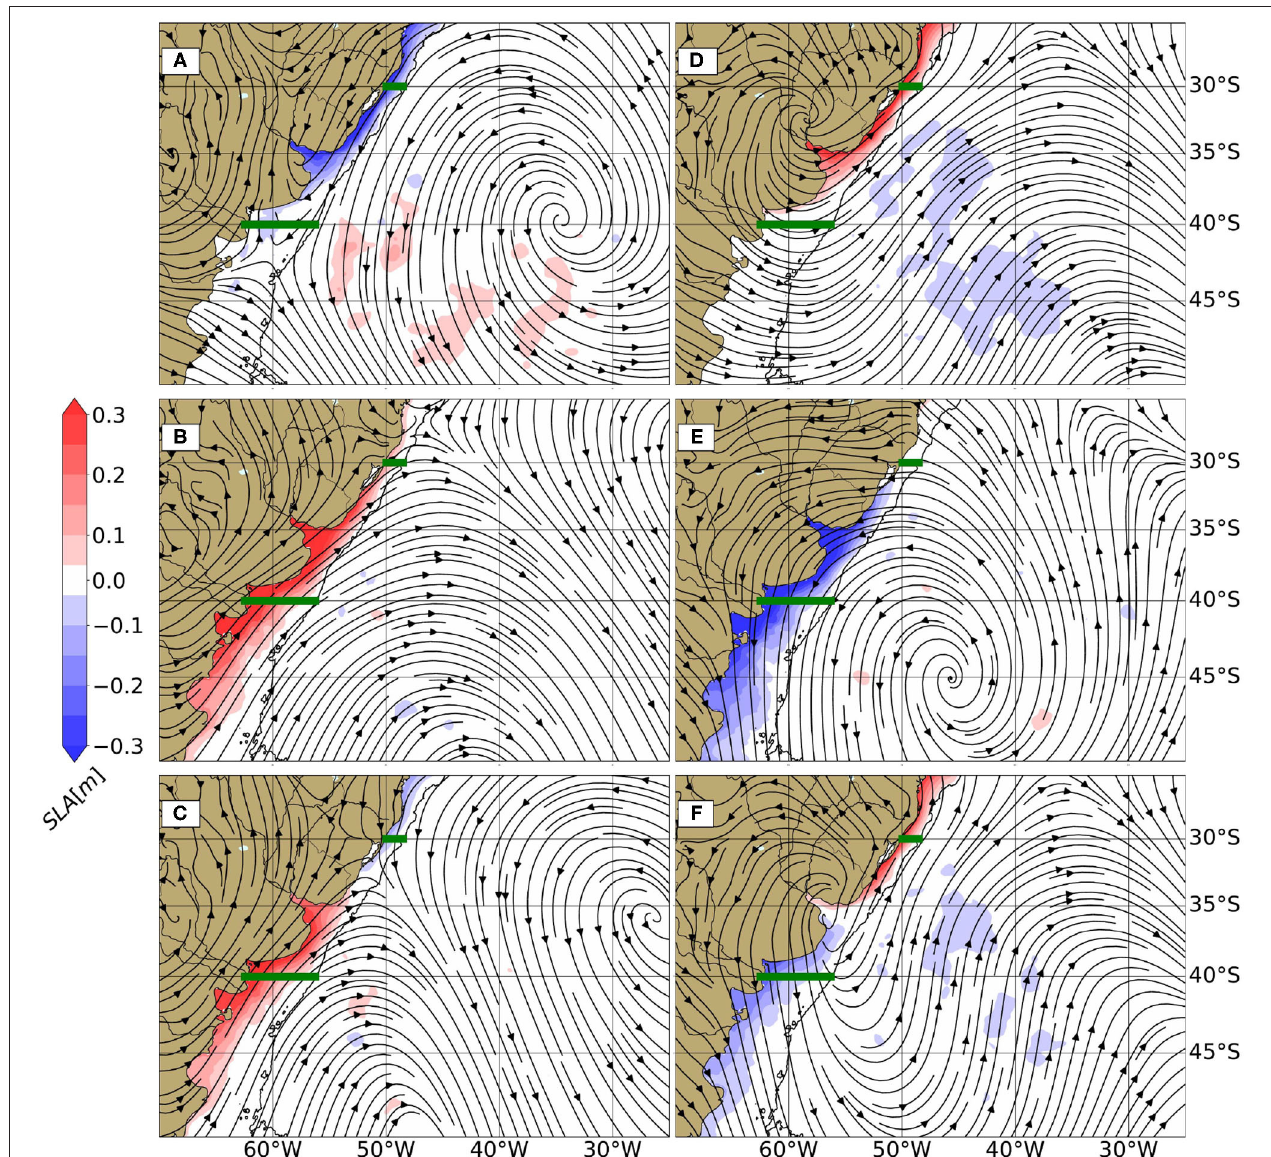
FIGURE 10 | Composite of model derived sea level anomaly (background color shading) and black streamlines show surface wind patterns during positive (A) and negative (D) extreme T N events. (B) and (E) , same as (A,D) for T S . (C) and (F) , same as (A,D) for T Cross . The 200 m isobath is indicated by a gray